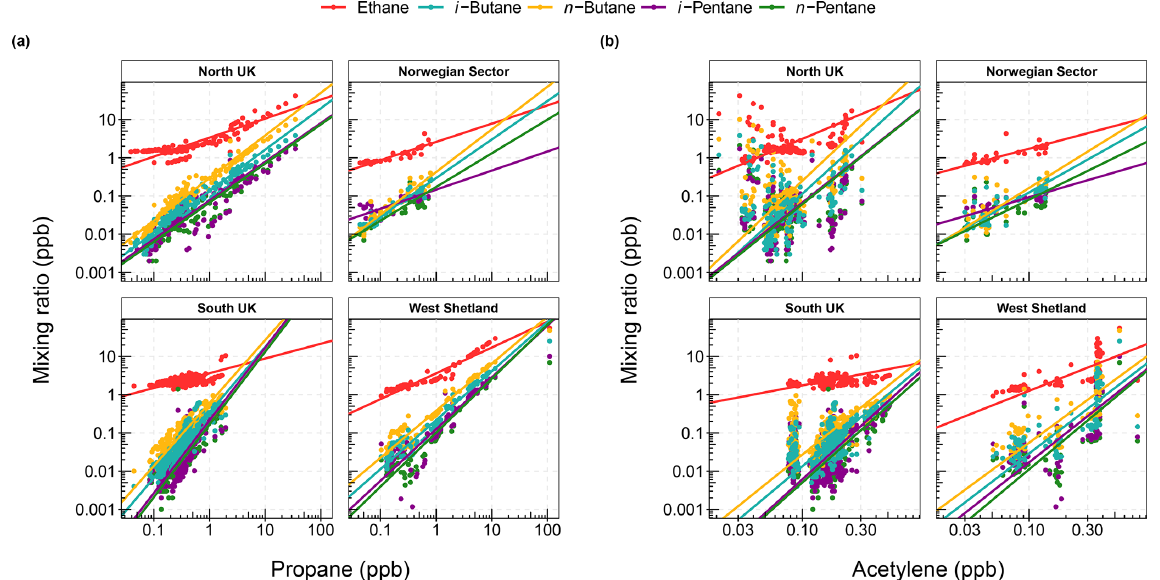
Figure 3. Correlation of light alkanes with (a) propane and (b) acetylene in each sampling region. The solid lines represent the linear fit using reduced major-axis regression. Note the log scale used on both